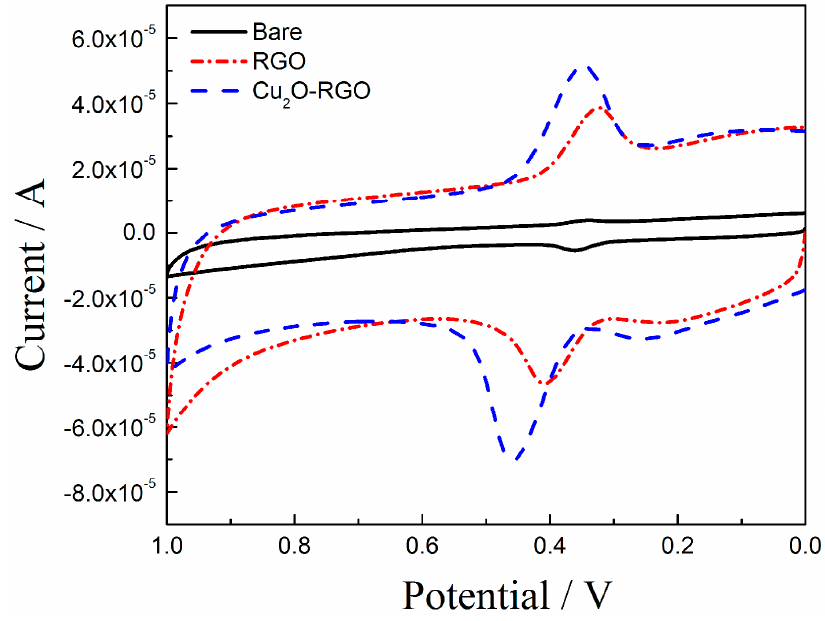
Figure 4. Cyclic voltamogramms obtain for 1 × 10 − 5 mol/L dopamine on bare GCE, RGO/GCE, and Cu 2 O-RGO/GCE in the presence of 0.1 M PBS (pH = 3.5) as supporting electrolyte. Scan rate: 0.1 V/s.